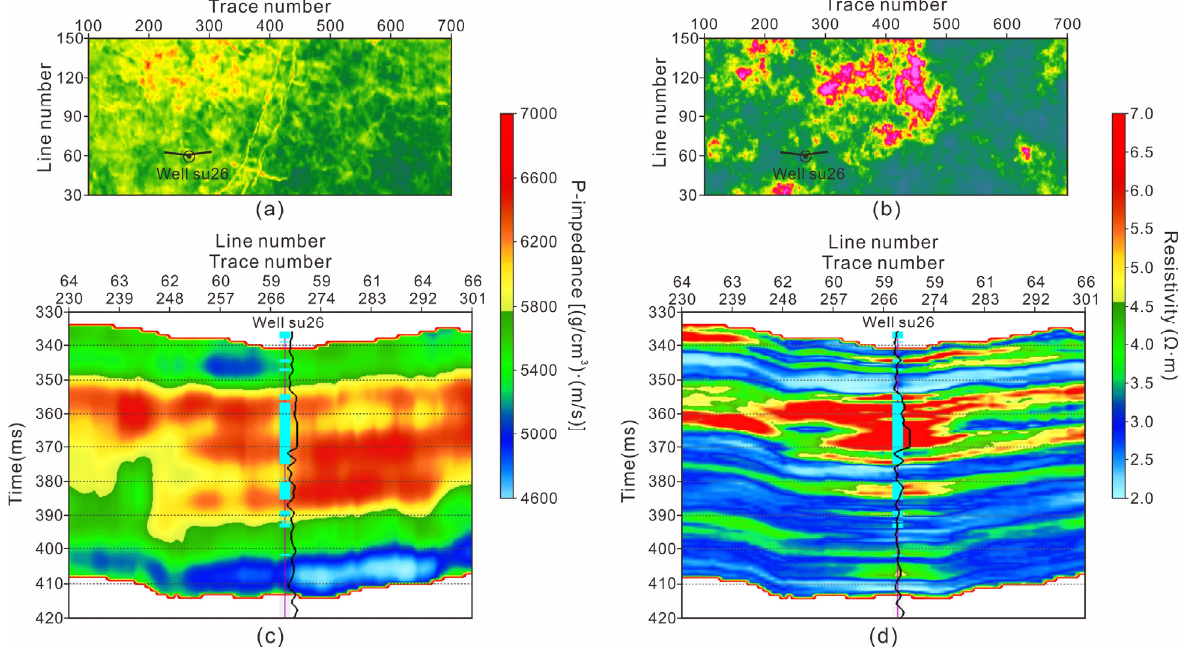
Figure 9. The numerical evaluation of inversion: ( a , b ) Qualitative evaluation by comparing the plane attributes of deterministic inversion and geostatistical inversion, ( c , d ) Quantitative evaluation by comparing the sand bodies (blue) in Well Su26 with the results of deterministic inversion and geostatistical inversion.